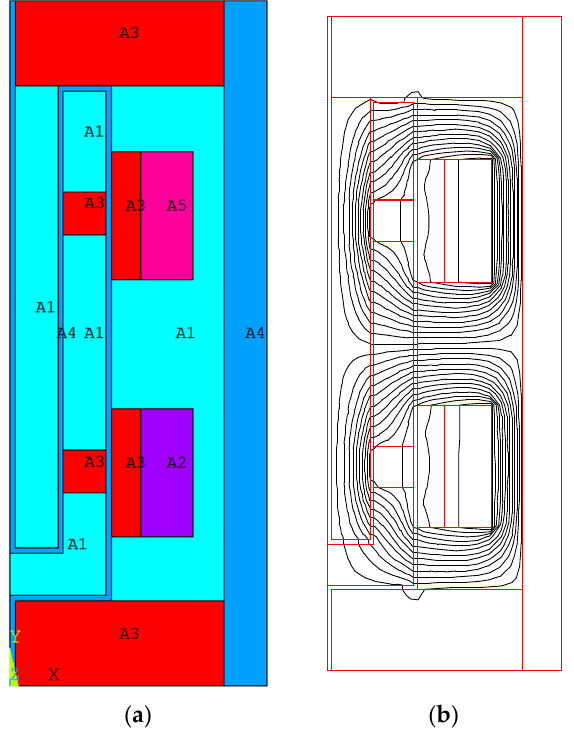
Figure 6. ( a ) simulation model diagram of the annular multi-channel MR valve; ( b ) shows the mag- netic field line distribution of the annular multi-channel MR valve. magnetic field line distribution of the annular multi-channel MR